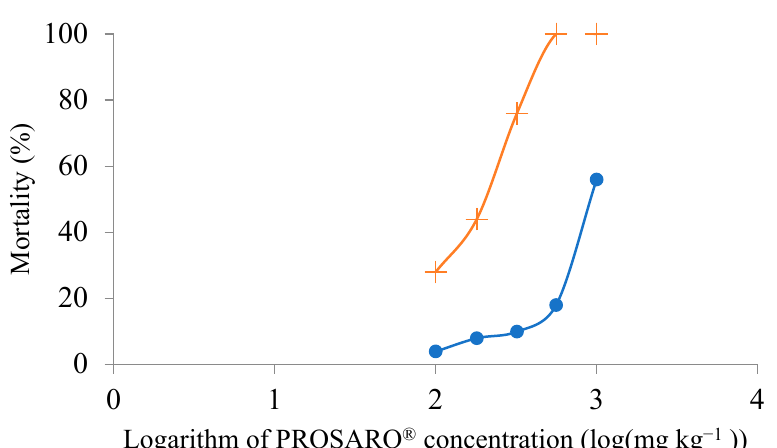
Figure 2. Mortality on day 14 for E. fetida (circle) and G. rione (cross) in Toxicity test 2 with increasing concentrations of PROSARO ® , from 1 × 10 2 to 1 × 10 3 L ha − 1 , which were the two highest concentrations in the sublethal experiment. See Table 2 for specifications on concentrations.